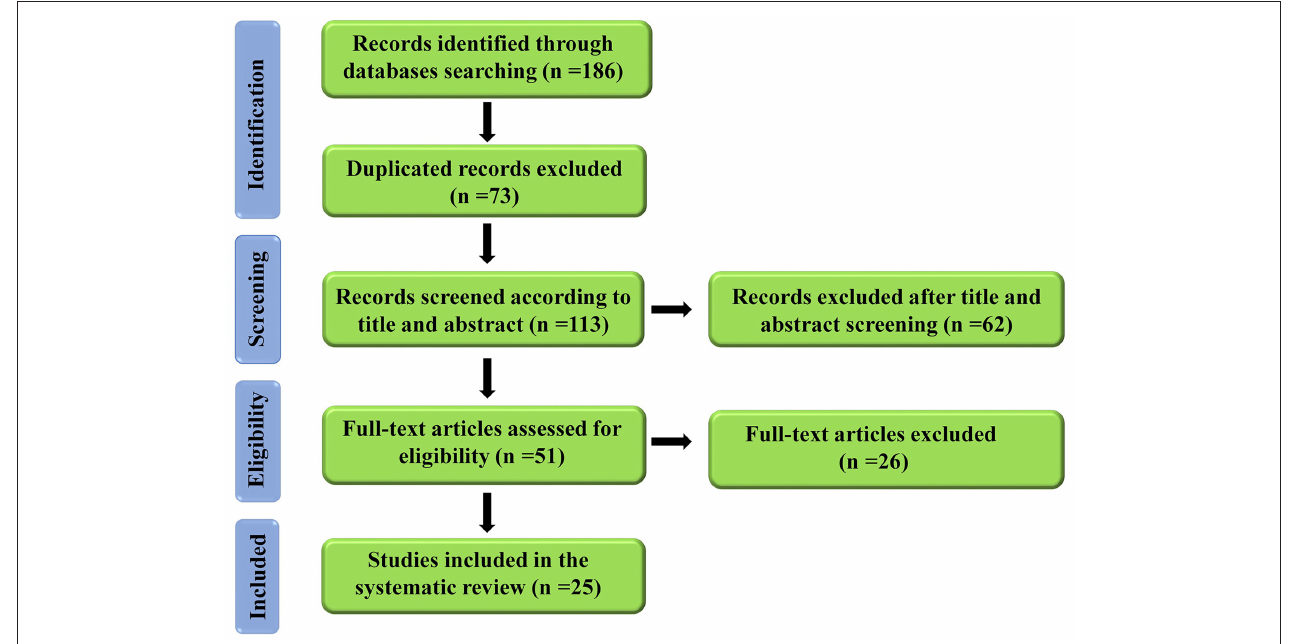
FIGURE 1 | A flow diagram of the selection process for the present